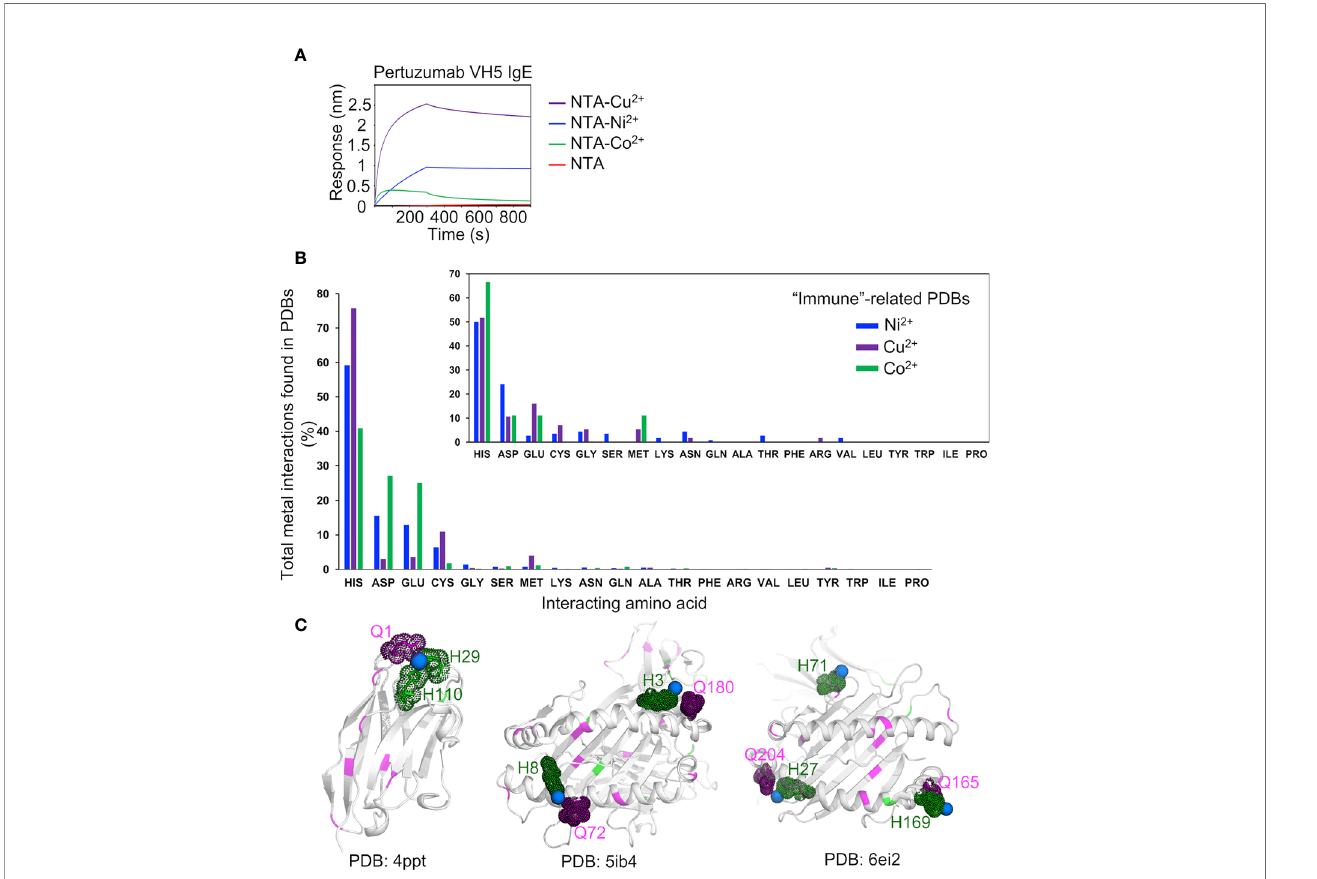
FIGURE 6 | Analysis of metal binding ability. (A) Binding responses of the Pertuzumab VH5 IgE variant to different metal ions (Ni 2+ , Cu 2+ , and Co 2+ ) recharged on the NTA sensors. (B) Numbers of the metal interactions in the retrieved protein-metal complexes from Protein Data Bank. The smaller offset plot showed the metal interaction results of a subset of immune-related protein complexes found by using independent keywords: “ immune ” , “ antibody ” , “ MHC ” , and “ TCR ” . (C) Structural presentation of a VHH antibody complexed with Ni 2+ (PDB: 4PPT), HLA-B*27:05 (PDB: 5IB4), and HLA-A68 (PDB: 6EI2) complexed with a peptide and Ni 2+ , where glutamines (magenta) are found to be involved in (e.g., in 4PPT) or closed to the Ni 2+ binding region with histidine (green). The Ni 2+ ions are represented by blue